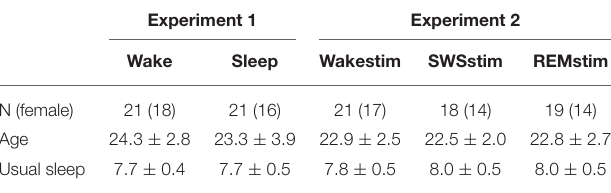
TABLE 1 | Description of the sample for Experiment 1 and Experiment